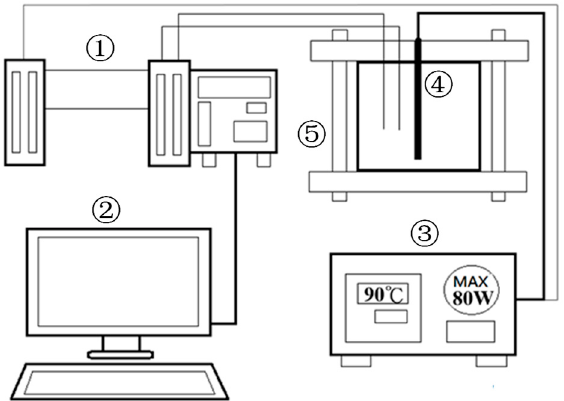
Figure 3. PC-based experimental system for the NP method. ① MX100 DAQ, ② computer, ③ heat supplier, ④ thermal needle probe, ⑤ steel frame.